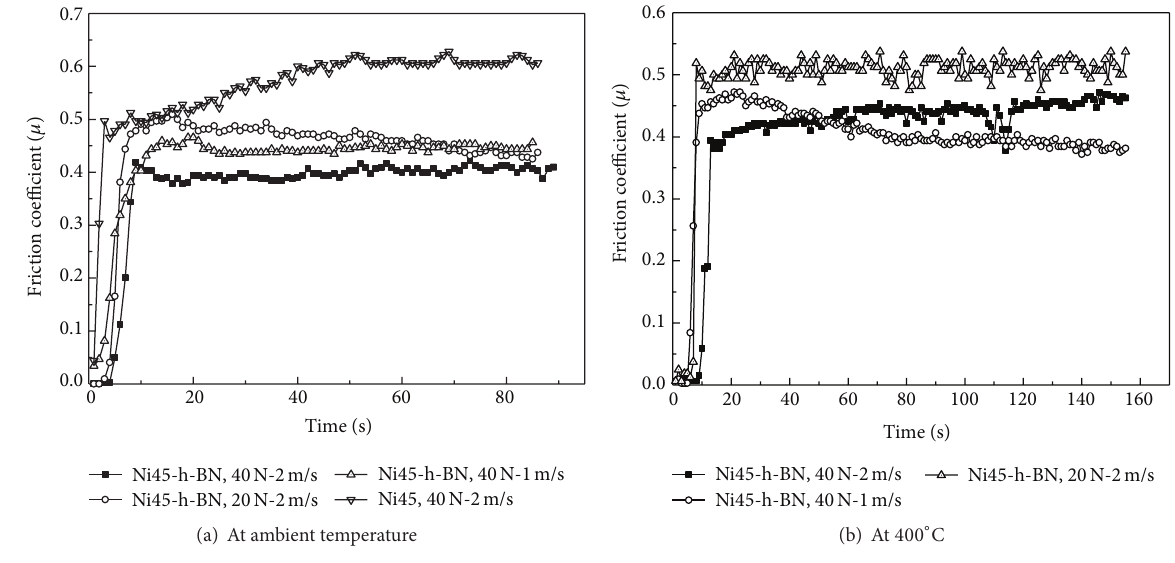
Figure 7: Friction coefficient of coatings at different temperature.